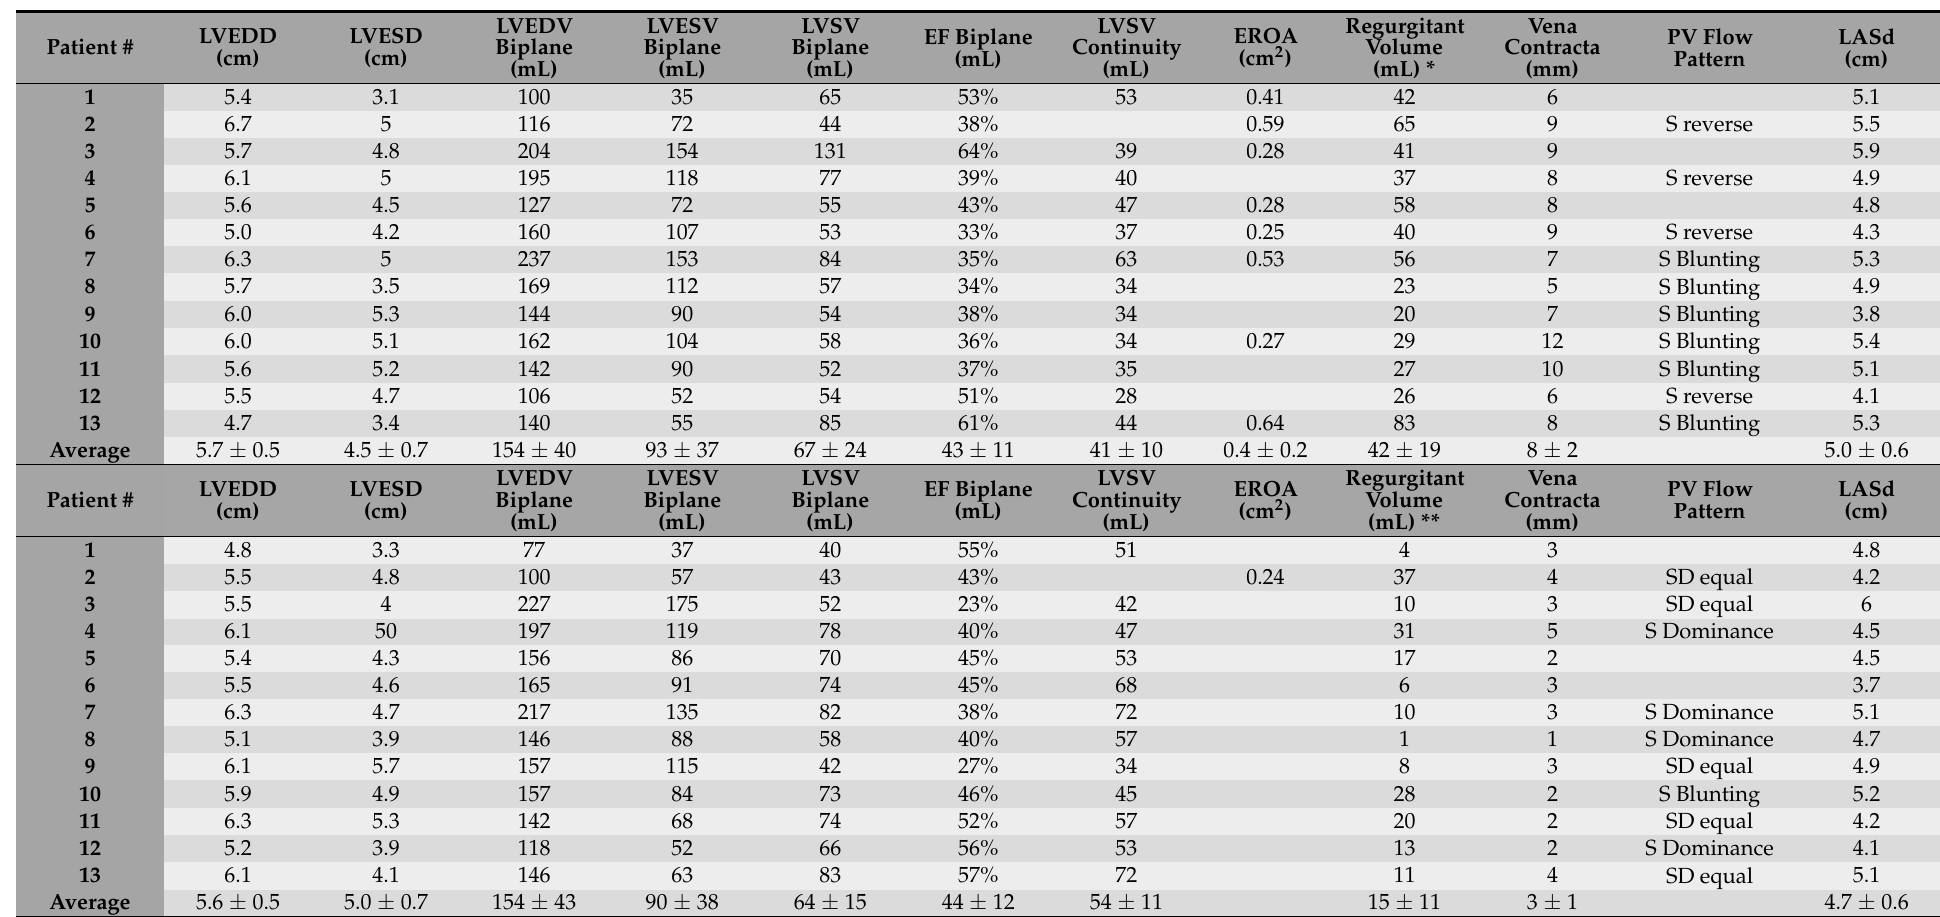
Table 2. Echocardiographic parameters before and after TEER: (a) echocardiographic parameter before TEER; (b) echocardiographic parameter after